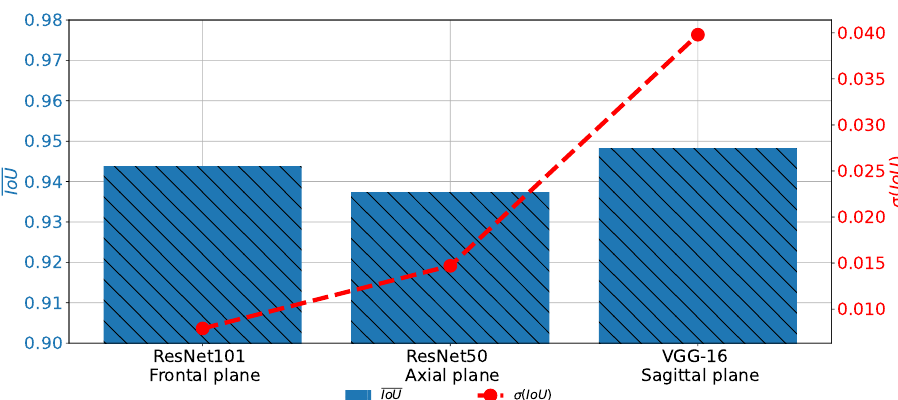
Figure 16. Comparison of IoU and σ ( IoU ) achieved with the most successful architectures for each